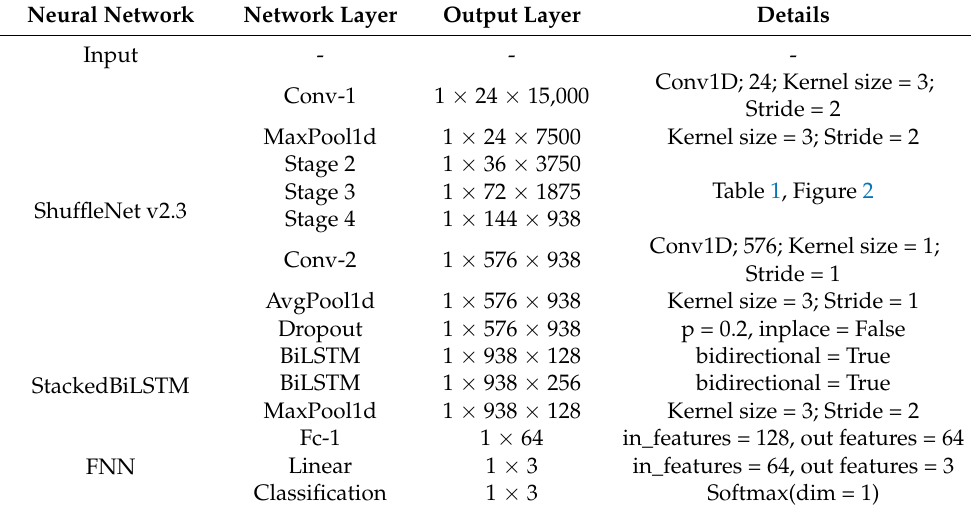
Table 2. Broaching tool state recognition model